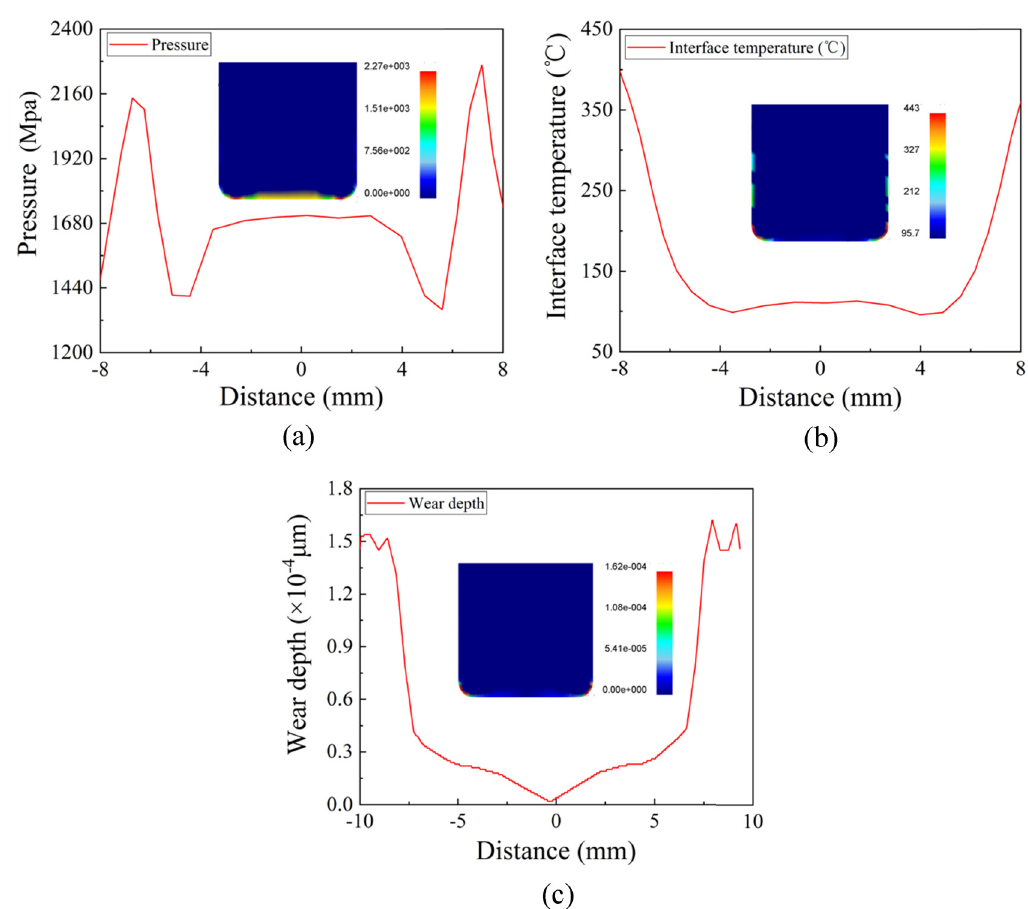
Figure 11: Nephograms of cold extrusion die corresponding to ( a ) interface pressure, ( b ) interface temperature, and ( c ) wear depth. Note: the curve represents the speci fi c value along the bottom boundary of the die; the bottom center is the original